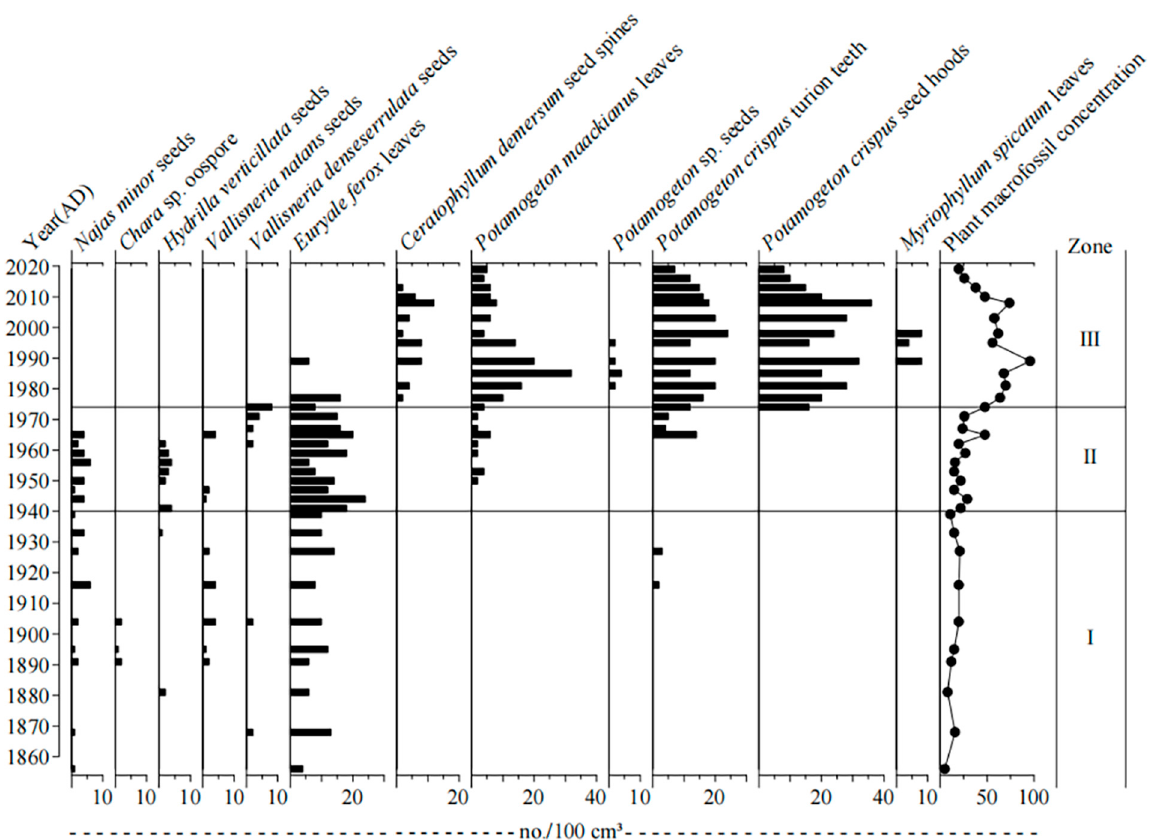
Figure 5. Vertical changes in aquatic plant macrofossils in the Huanggai Lake core.